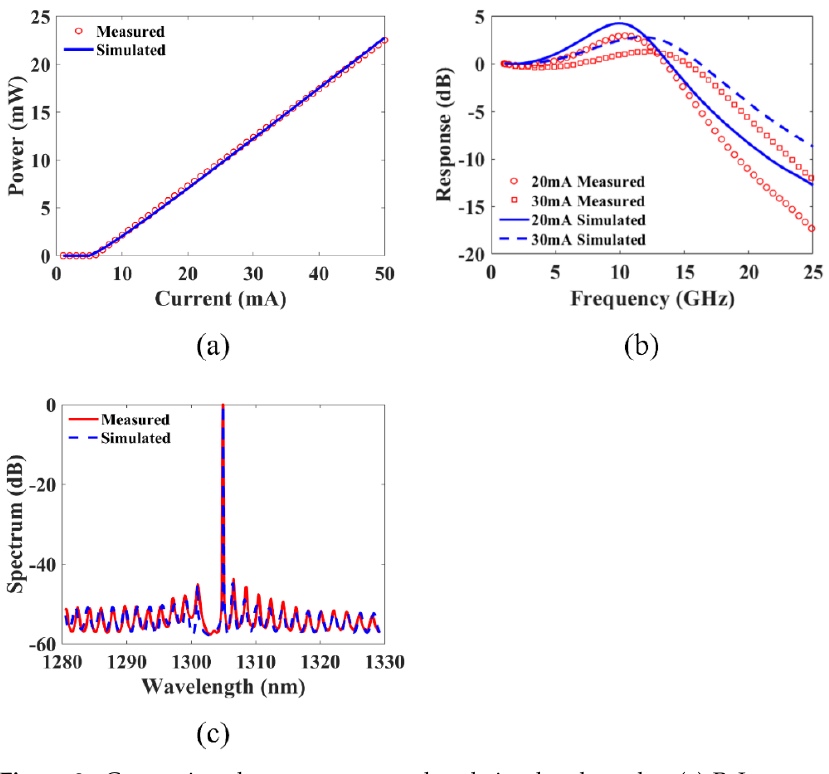
Figure 2. Comparison between measured and simulated results: ( a ) P–I curve; ( b ) Modulation response; ( c ) Spectrum.